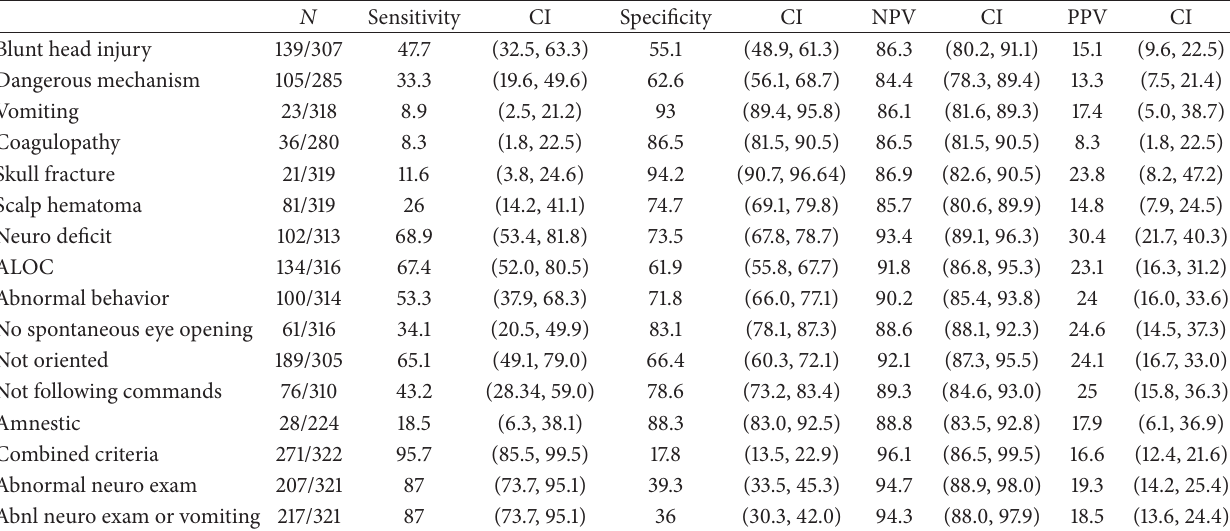
Table 3: Test characteristics of history and physical examination findings in relation to clinically abnormal head CTs.